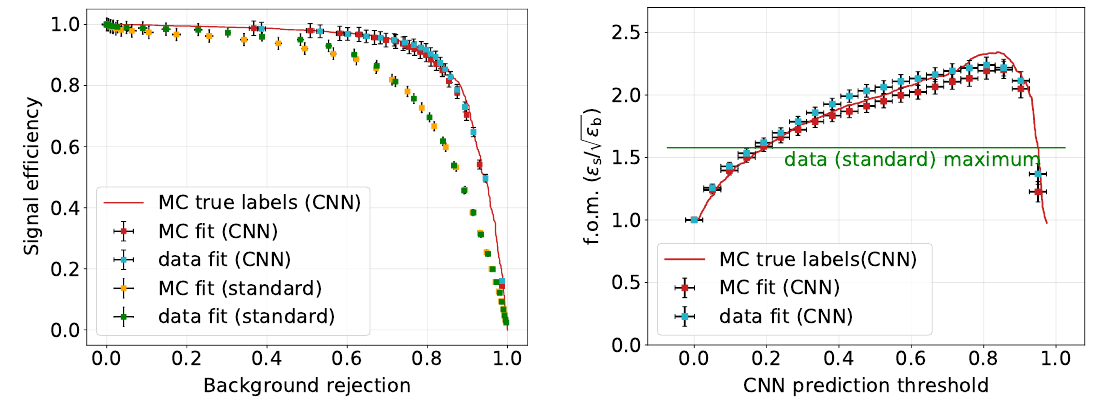
Figure 10 . The signal acceptance vs. background rejection (left) and the figure of merit (right). The curves labeled “fit” are traced out by varying the neural network classification threshold and de- termining the fraction of accepted signal and rejected background using the fit procedure described in the text, while the MC true labels are obtained using MC labels as described in section